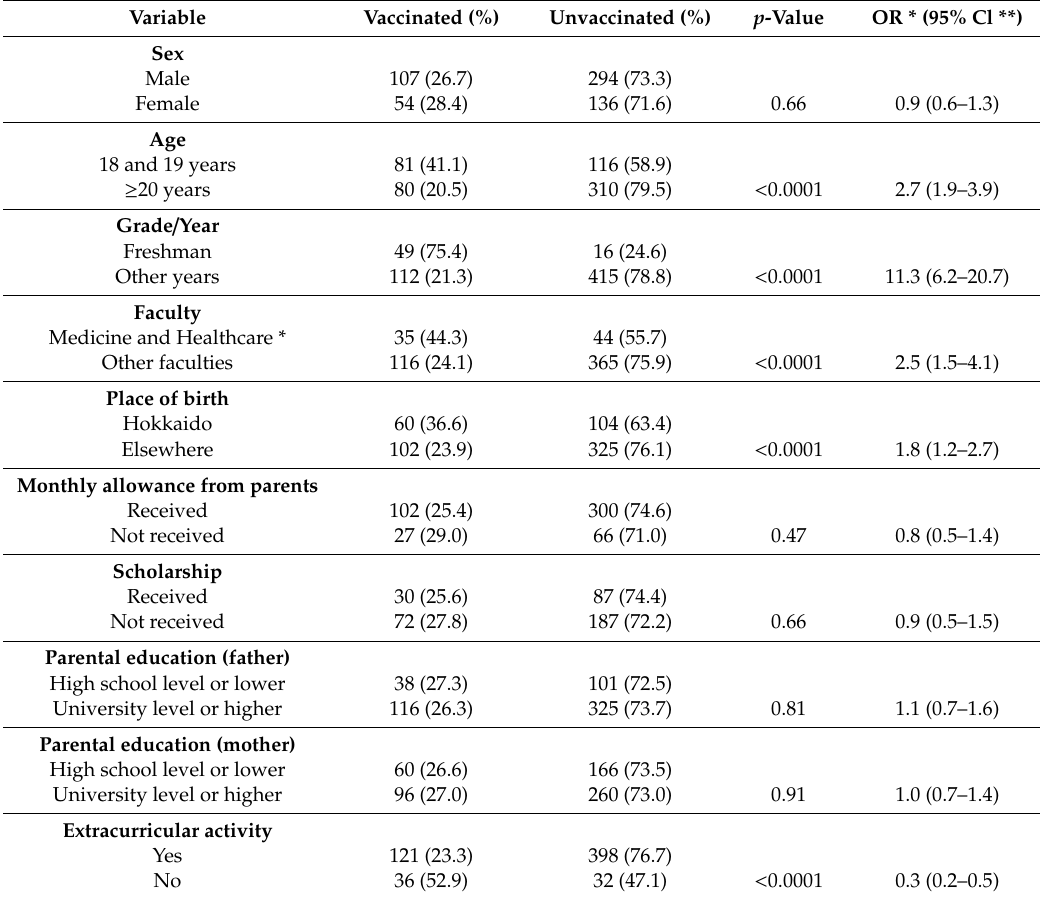
Table 2. Frequency of influenza vaccination according to Hokkaido University students’